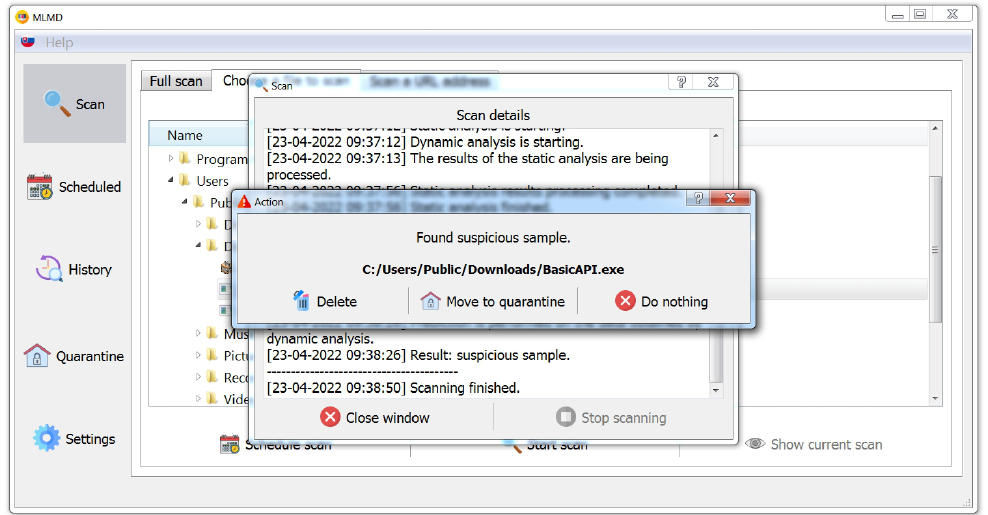
Figure 8. Action on a scanned file.